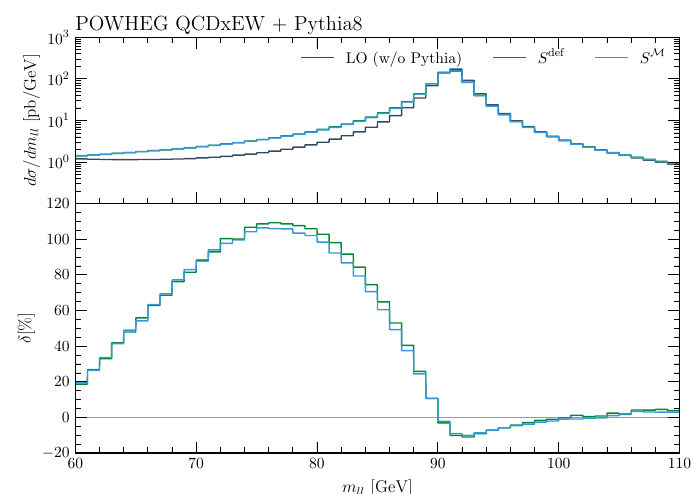
Figure 3 : The invariant-mass distribution of the lepton pair is shown at LO (without parton shower) and including QCD and EW e(cid:11)ects within the Powheg method. Pythia 8 is used as a parton shower. The lower plot shows the relative corrections with respect to the LO result. In particular, the resonace-improved result S M is compared to the standard choice for the S functions S def .